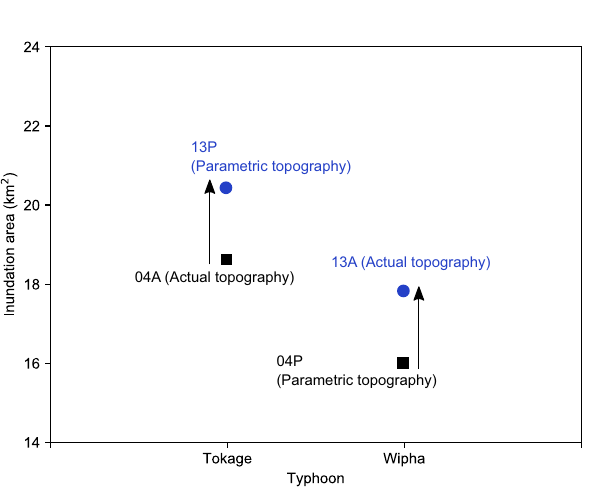
Figure 3. Quantification of the inundation areas considering the effects of land surface elevation changes in the Ichinomiya River watershed. 04A and 04P are the cases with the topographies before the earthquake, while 13P and 13A are those after the earthquake, which represents the results considering the influence of earthquake- induced land surface elevations.